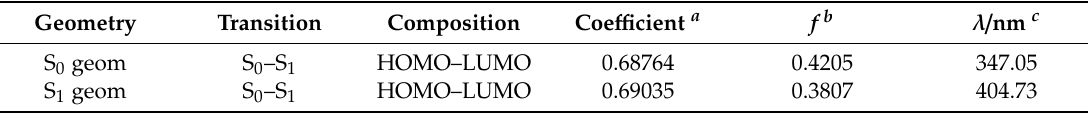
Table 4. Results of TD-DFT